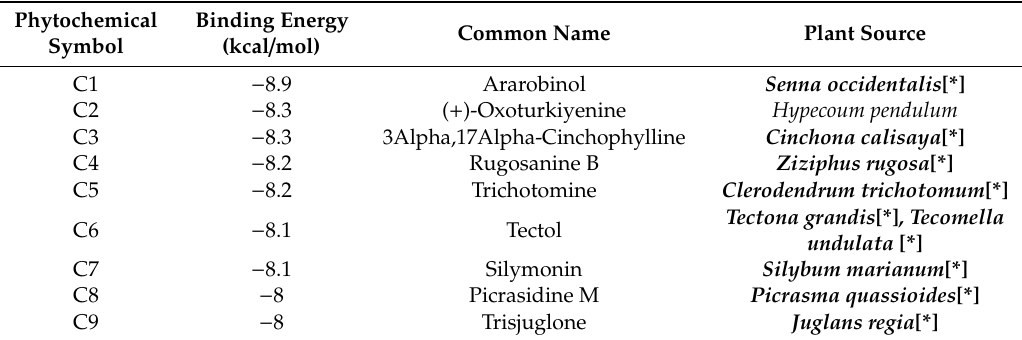
Table 2. Herbal sources of top 9 phytochemical inhibitors of Cathepsin L. For each phytochemical, the table gives the symbol, docked binding energy, common name and plant source. Plant sources which have been reported to have antiviral or anti-inflammatory use in traditional medicine literature are shown in bold and marked with an [*]